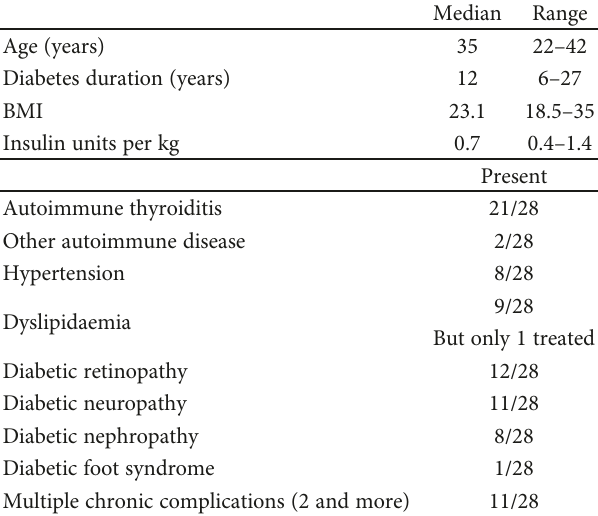
Table 1: Clinical characteristics of the study